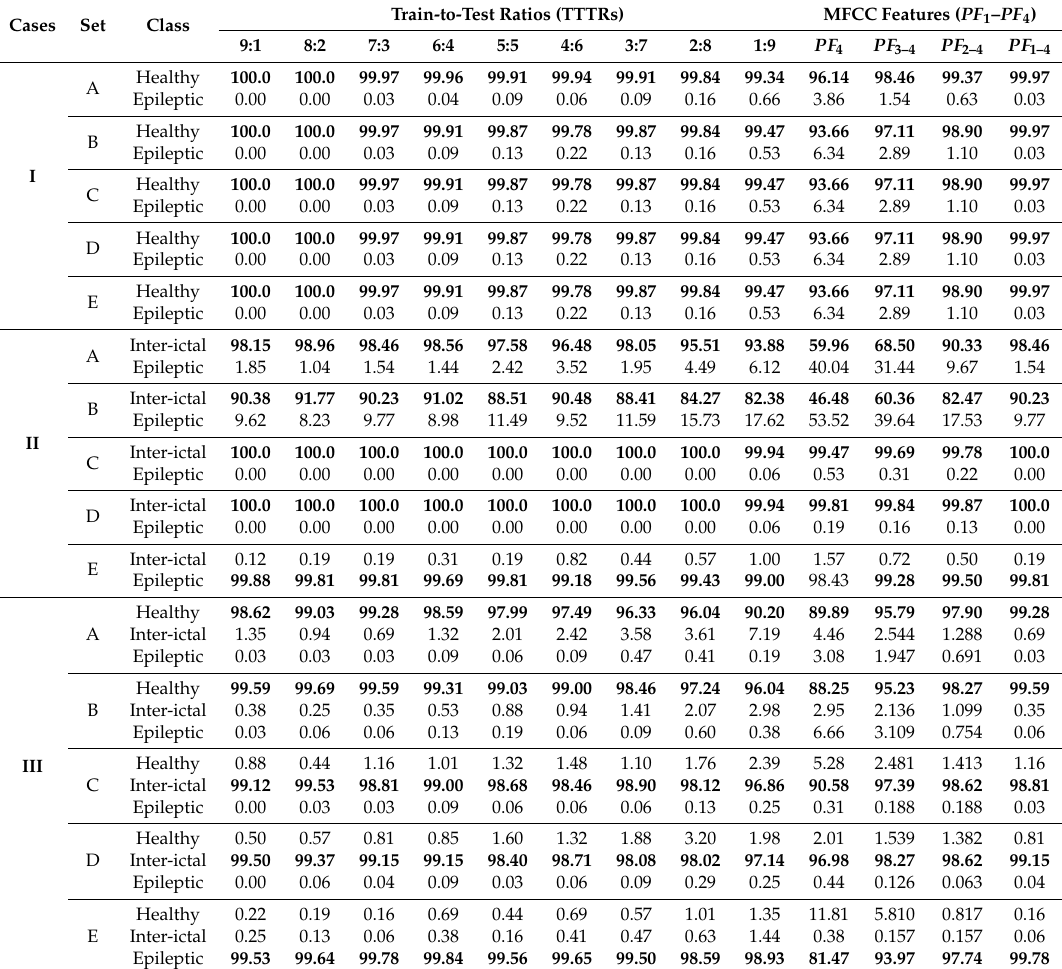
Table 7. Average results obtained by the five classifiers after classification on variety train-to-test ratios (TTTRs) and variety numbers of Mel-frequency cepstrum coefficient (MFCC)